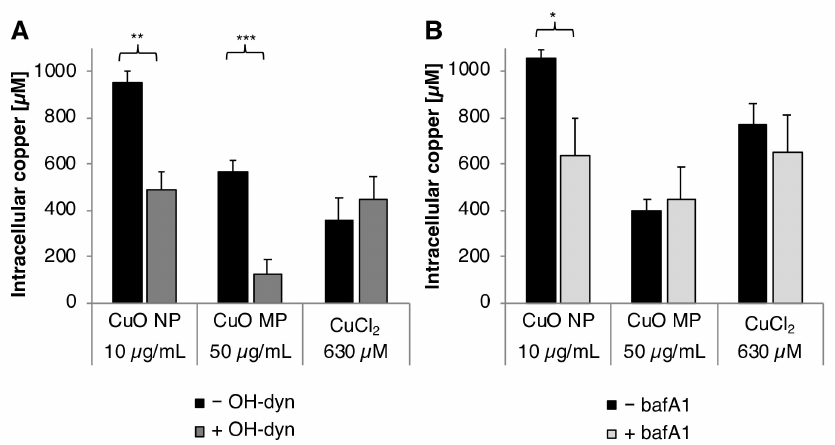
Figure 2. Cellular copper uptake after treatment with CuO NP, CuO MP or CuCl 2 in the presence or absence of ( A ) OH-dyn and ( B ) bafA1. Copper content was determined in the soluble fraction of BEAS-2B cells after 8 h treatment, with the di ff erent copper compounds co-treated with or without OH-dyn, or after 24 h co-treated with or without bafA1, respectively, via GF-AAS. Shown are the mean values of three independent experiments + SD. Statistically significant di ff erent from the respective copper compound treatment: * p ≤ 0.05, ** p ≤ 0.01, *** p ≤ 0.001 (T-test). 50 µ g / mL CuO are equal to 630 µ M Cu 2 +